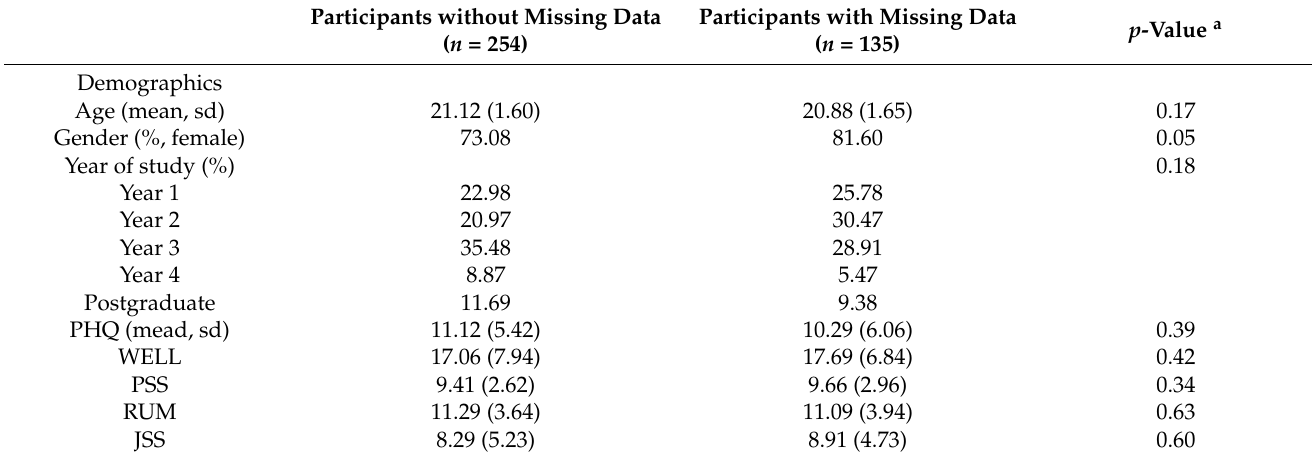
Table 1. Baseline characteristics of participants with and without missing data at